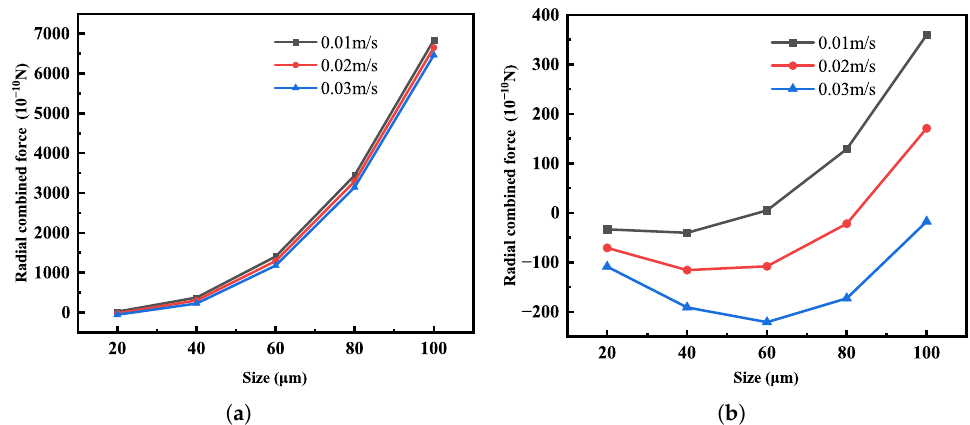
Figure 9. Radial combined forces on different types of particles as a function of particle size and radial water flow rate. ( a ) Ilmenite, ( b ) Gangue